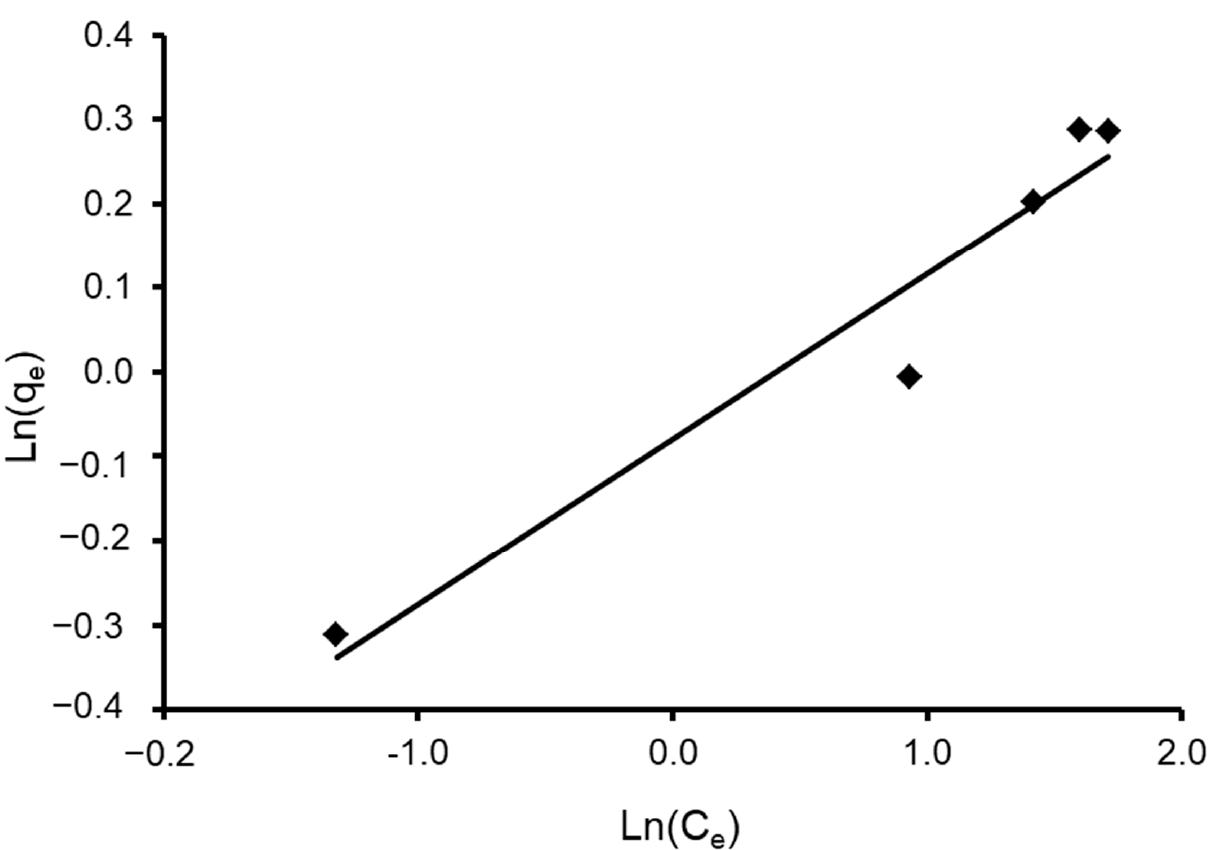
Figure 13. Plot of the Halsey isotherm model for CVD adsorbed onto S. costatum .